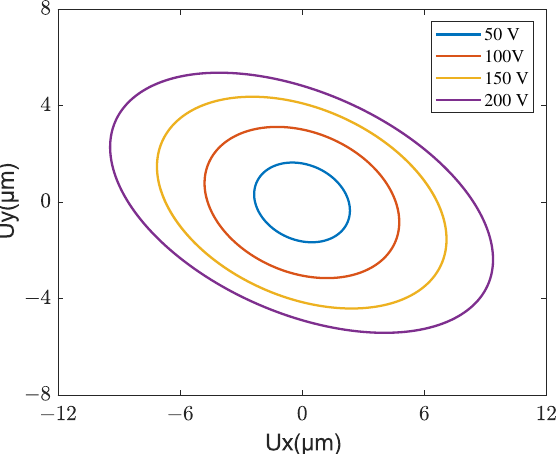
Figure 29. Driving trajectory of the contact tip for different voltage amplitudes. The steady-state velocities of a mover for different frequencies of driving voltage are tested and simulated, as shown in Figure 30. The voltage amplitude and the phase difference are fixed as 100 V and 90 ◦ , respectively. Within the frequency range from 52 to 55 kHz, the mover velocity rises first and starts to decline after passing 53.4 kHz which is called the motor reasonable frequency. The motor resonant frequency is higher than the designed stator resonant frequencies (53.3 kHz), which can be attributed to the effect of the stator–mover contact behaviors. The driving trajectories of the contact tip for several excitation frequencies near the motor resonant frequency are given in Figure 31. The solid and dashed lines denote the frequency below and above the stator resonant frequency, respectively. Additionally, the trajectories are clockwise directions. The excitation frequency not only affects the size of the elliptical trajectory but also the response phase